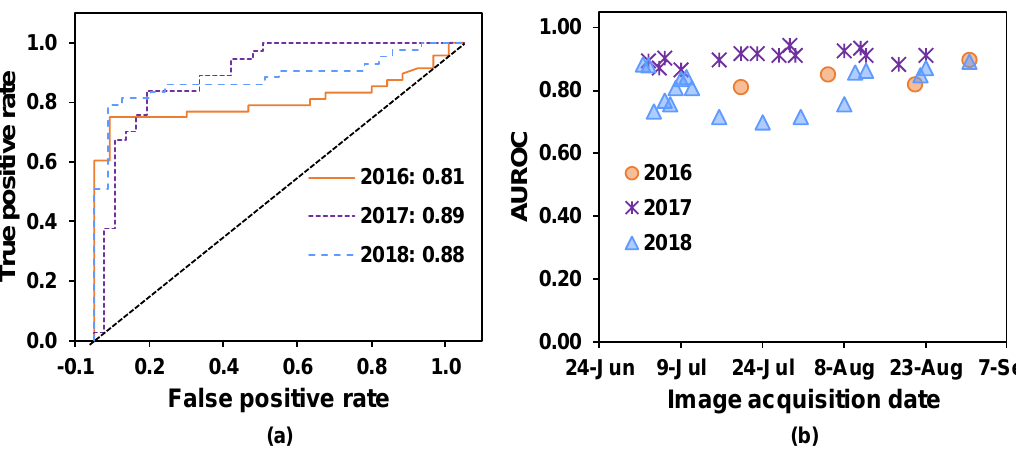
Figure 8. ( a ) Examples of receiver operating characteristic (ROC) plots for classification of SDS-infected soybean quadrats based on reflectance data from satellite images obtained in 2016 (July 20), 2017 (July 3), and 2018 (July 2). Values after colons indicate AUROC values. ( b ) AUROC values achieved by random forest trained models used to detect healthy and SDS-infected soybean quadrats.